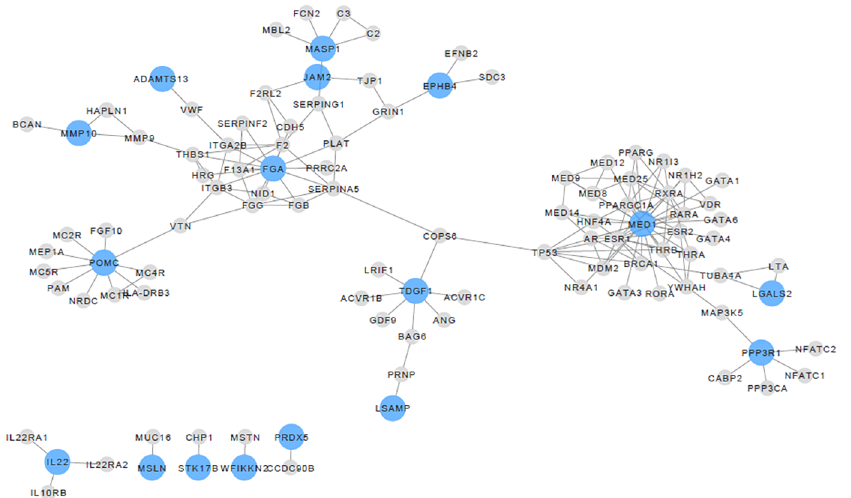
Fig 3. Network displaying proteins significantly associated with beta-cell function/HOMA-IR and their direct interactions. The nodes represent proteins and the edges represent protein-protein interactions. Proteins significantly related to beta-cell function/HOMA-IR are in blue (p (cid:20) 0.01) and grey nodes are their direct interactions. 17/22 proteins significantly associated with beta-cell function/HOMA-IR have direct